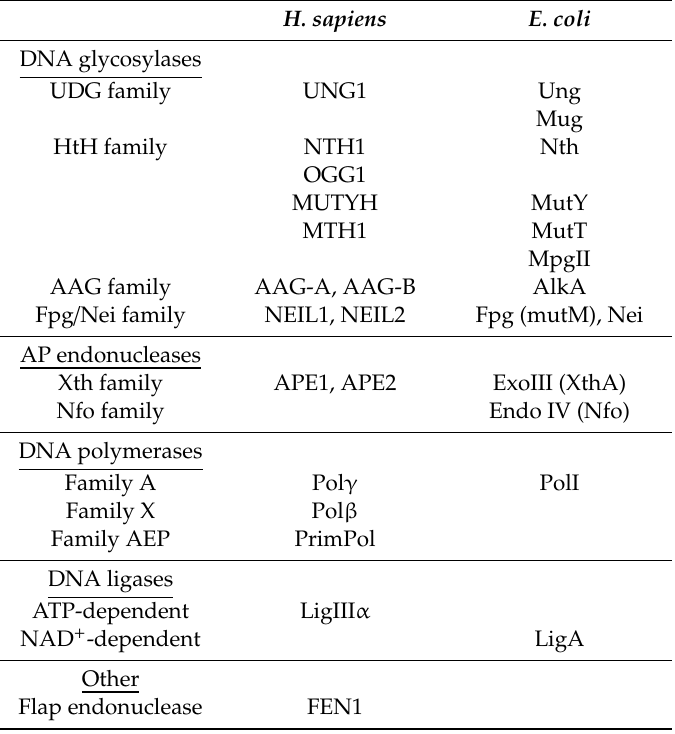
Table 1. The BER system’s main proteins in human mitochondria and bacteria [151,155,161,162]. H.